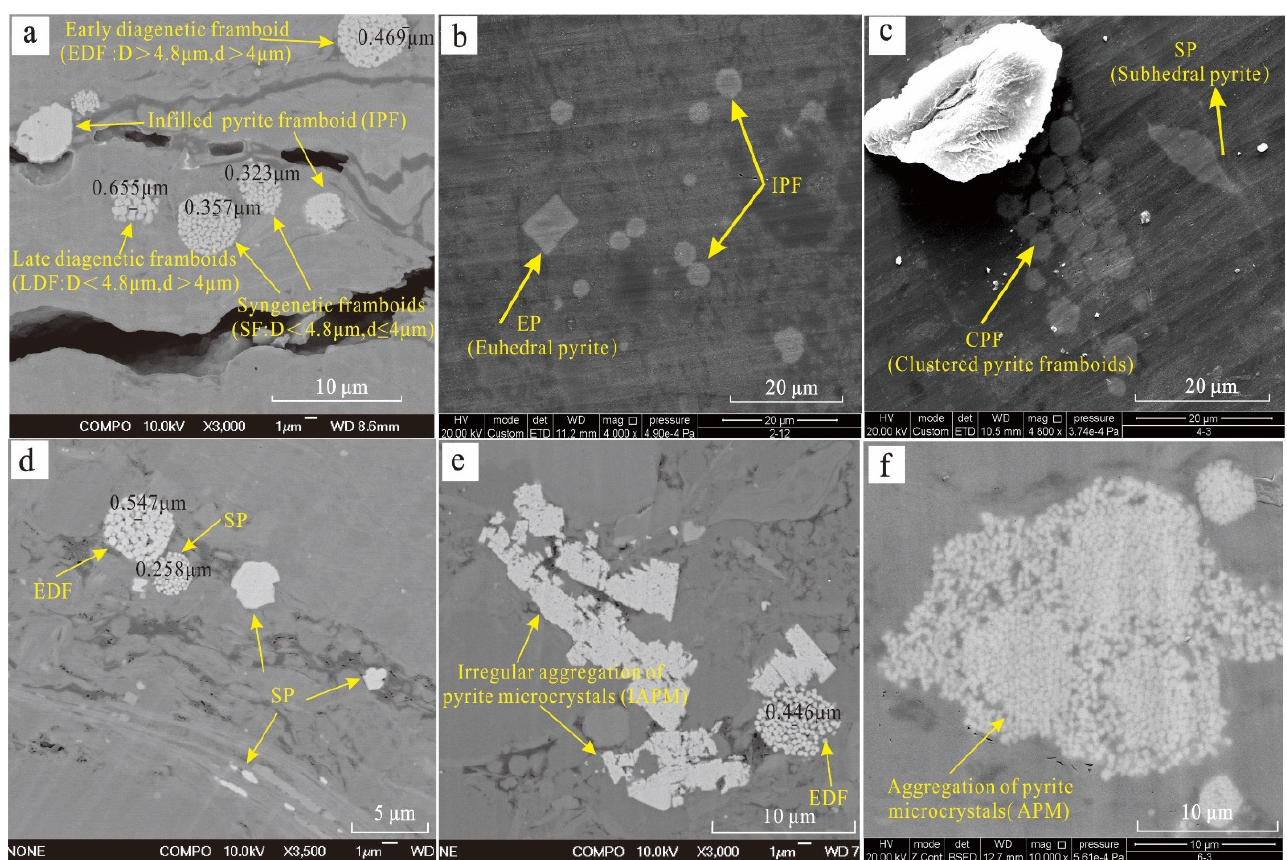
Figure 3. Pyrite micromorphology in the Longmaxi and Wufeng Formations. ( a ) Syngenetic fram- boids (SF), early diagenetic framboids (EDF), late diagenetic framboids (LDF) and infilled pyrite framboids (IPF) in the Longmaxi silty shale, 2330.46 m, well JY1; ( b ) infilled pyrites framboids (IPF) and euhedral pyrites (EP) in the Longmaxi black silty shale, 17.43 m, well X; ( c ) euhedral pyrites (EP) and clustered pyrite framboids (CPF) in the Longmaxi black silty shale, 45.91 m, well X; ( d ) syngenetic framboids (SF), early diagenetic framboids (EDF) and euhedral pyrites (EP) in Longmaxi black-gray silty shale, 2346.5 m, well JY1; ( e ) early diagenetic framboid (EDF) and irregular aggregation of pyrite microcrystals (IAPM) in the Longmaxi shale, 2397.13 m, well JY1; ( f ) aggregation of pyrite microcrystals (APM) in the Wufeng black shale, 72.78 m, well X.